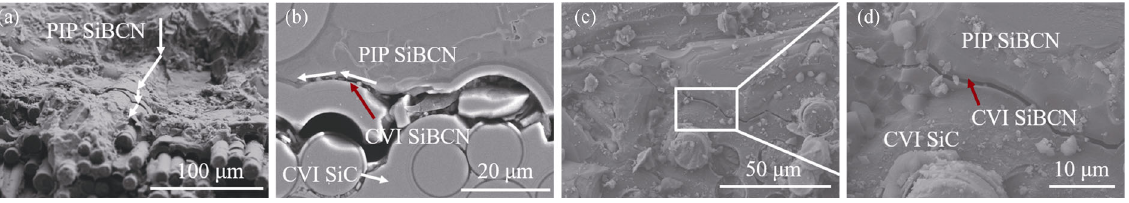
Fig. 5 Crack deflection in multiphase matrix: (a, b) 1#, (c) 2#; (d) the area in the box of (c) ((a, c, and d) are fresh fractures, and (b) is originating from the polished sample at the center area of 1# after three-point bending